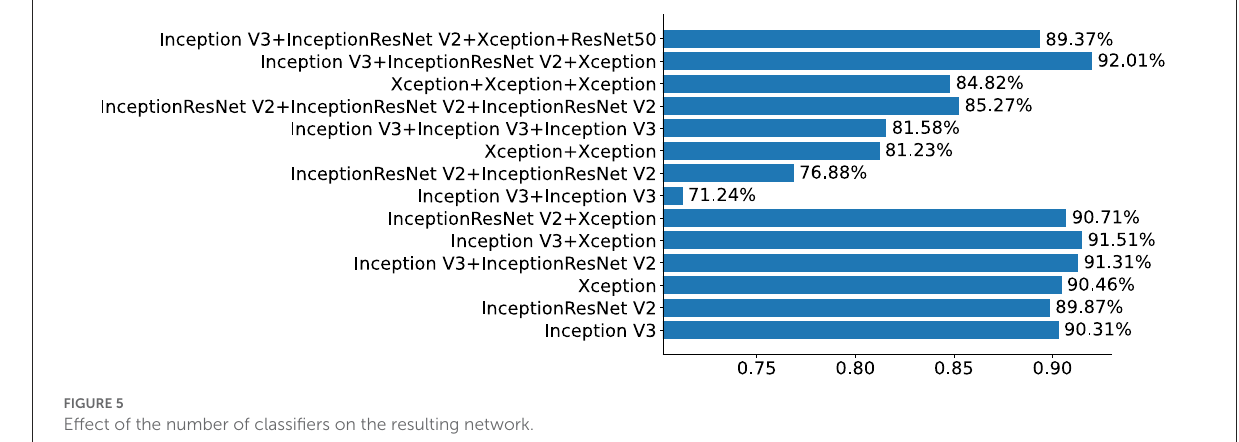
algorithm models: “Inception V3 + CBAM,”